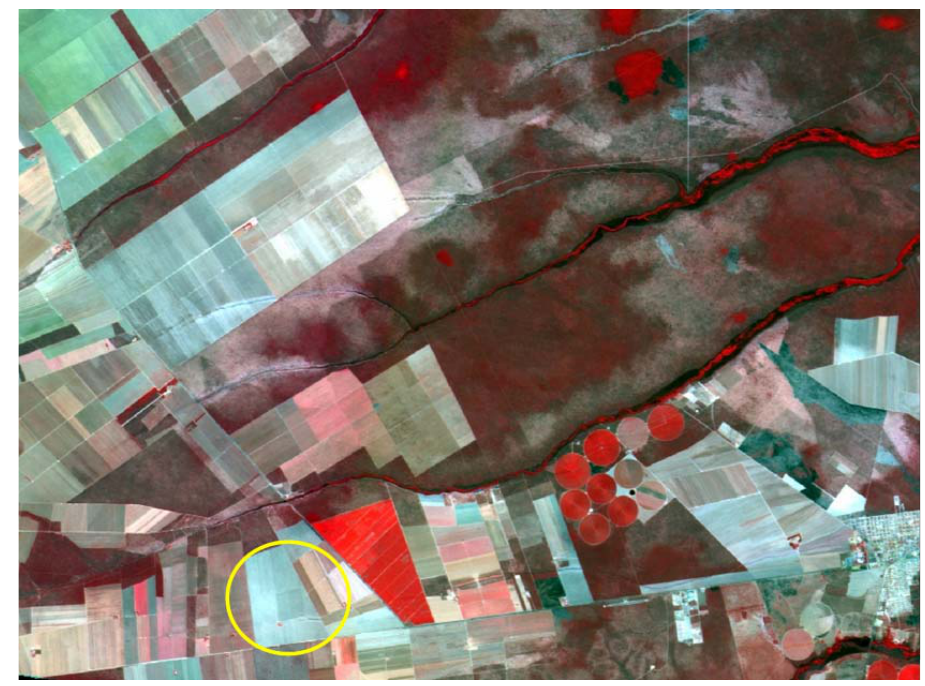
Fig. 1 – CCD-2 (green), CCD-3 (blue) and CCD-4 (red) color composition from the calibration test site. Yellow ring indicates the reference